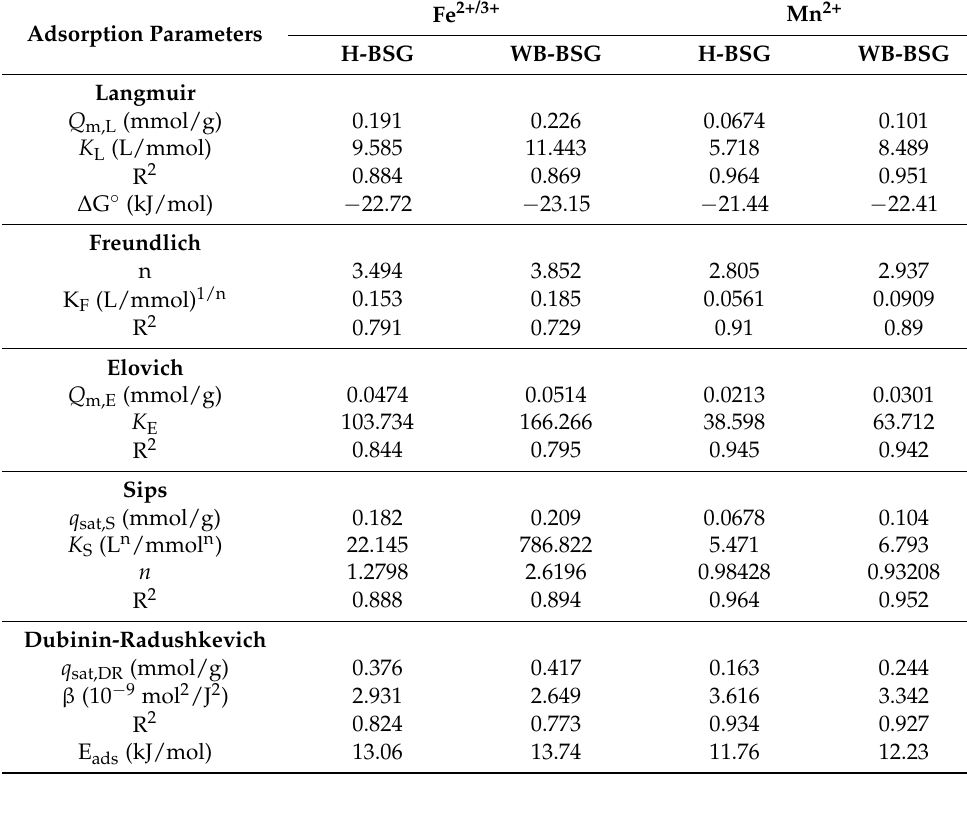
Table 4. Fitting parameters for Fe 2+/3+ and Mn 2+ adsorption onto H-BSG and WB-BSG for Sips, Langmuir, Freundlich, Elovich and Dubinin–Radushkevich isotherm models. Data from batch